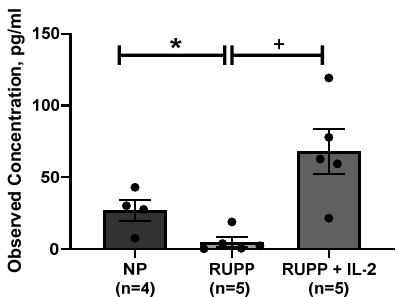
Figure 7. Comparison of IL-2 cytokine levels demonstrated that RUPP sera ( n = 5) was lower com- pared to RUPP rats treated with a low dose of recombinant IL-2 ( n = 5) and NP controls sera ( n = 4). Results were reported as means ± SEM and considered statistically significant when p < 0.05. (* p < 0.05 vs. NP control; + p < 0.05 vs. RUPP).